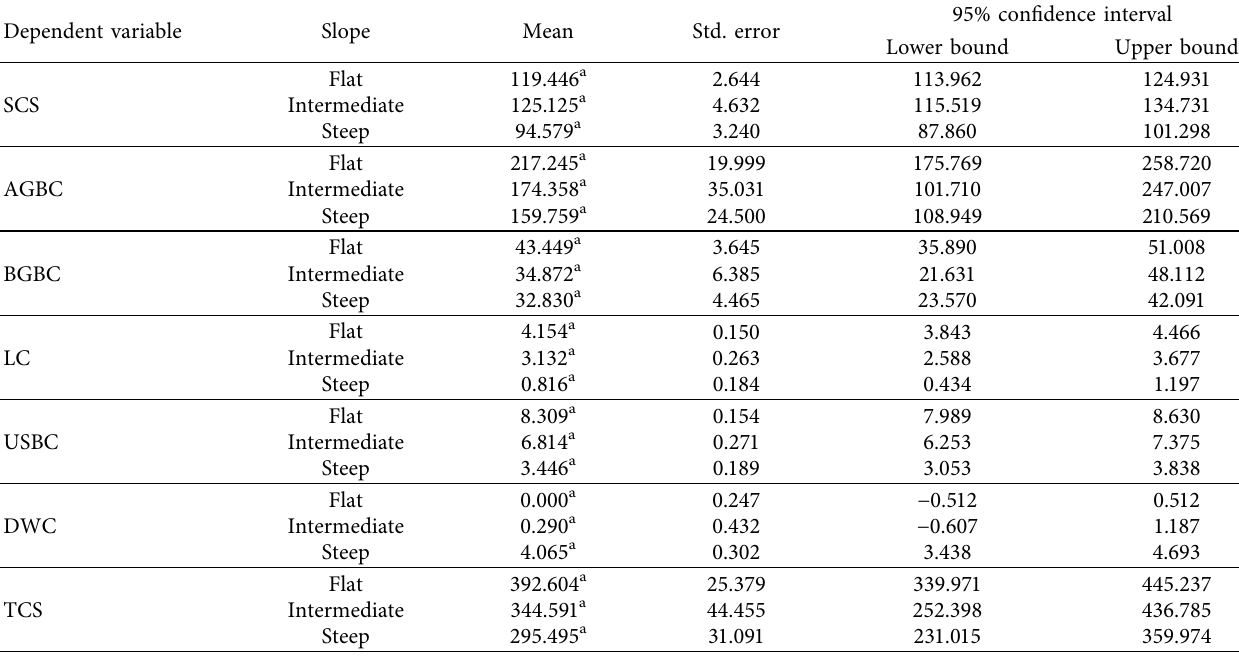
Table 11: Estimated marginal means of slope in Anshirava forest.